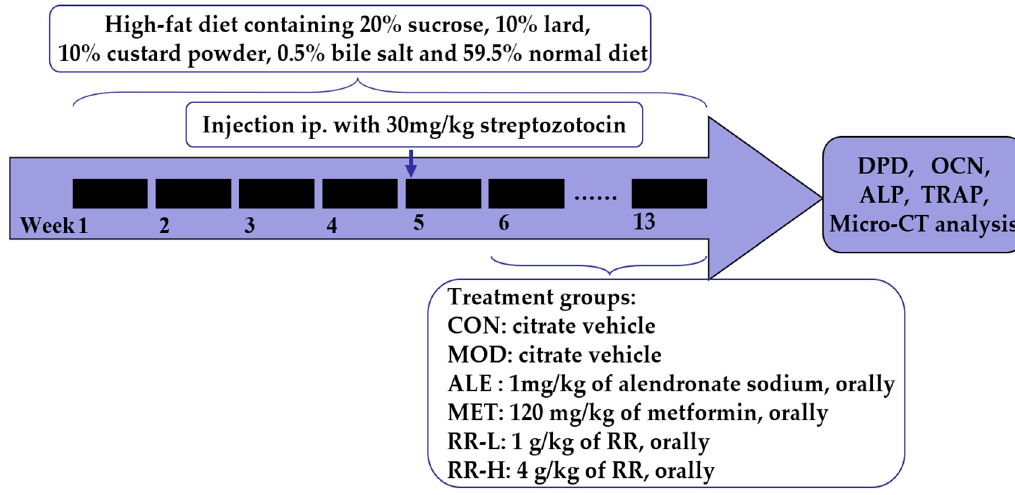
Figure 10. Animal experimental procedures. Wistar rats were fed with a high-fat diet for 4 weeks, and then intraperitoneally injected with streptozotocin to induce hyperglycemic syndrome, and then treated with RR, alendronate sodium and metformin for an additional 8